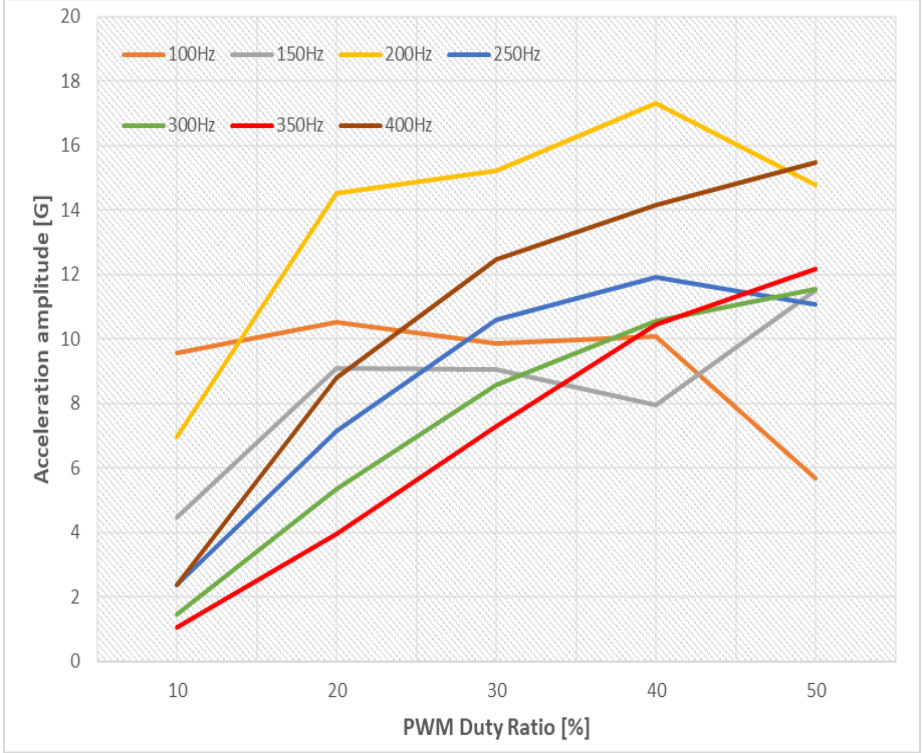
Figure 4. Variation of acceleration amplitude at different PWM duty ratios for different frequen- cies.